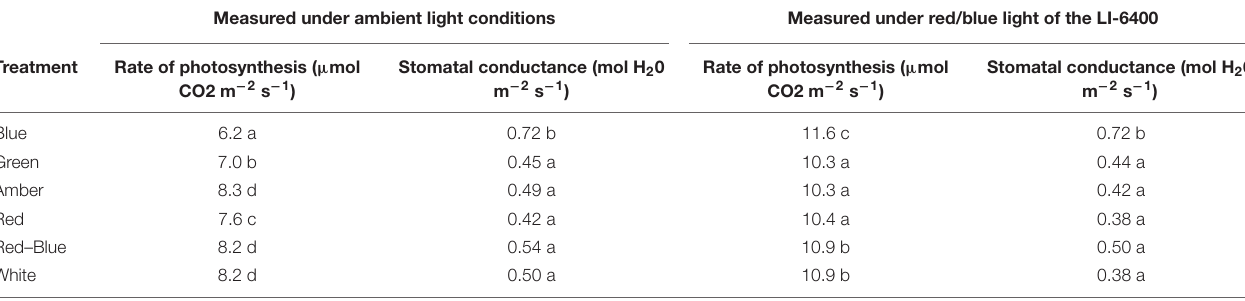
TABLE 4 | Effects of spectral composition of the light on rate of photosynthesis and stomatal conductance. Measured under ambient light conditions Measured under red/blue light of the LI-6400 Treatment